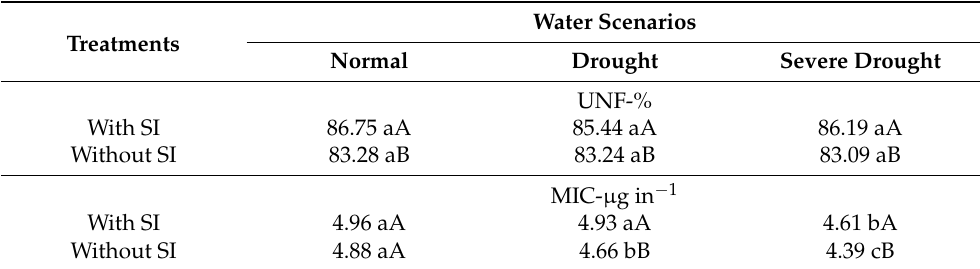
Table 6. Fiber uniformity (UNF) and micronaire index (MIC) of cotton, as a function of water scenarios and supplemental irrigation with treated